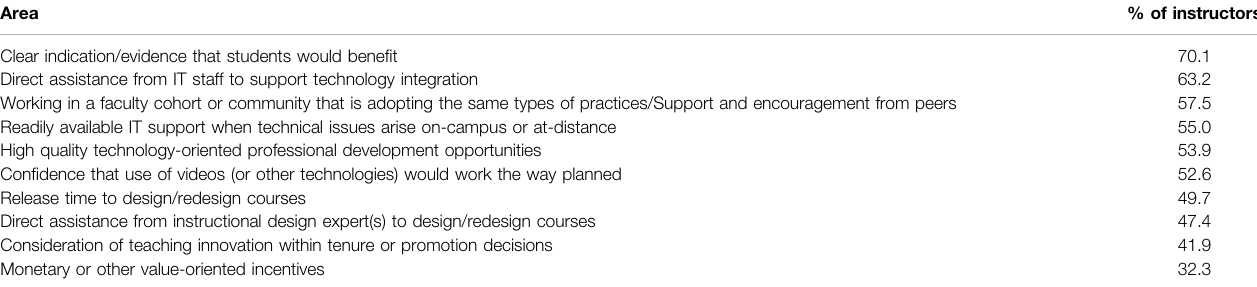
TABLE 2 | Percentage of instructors having ranked the importance of each area between 1 – 3 (1 (cid:1) highest importance ... 10 (cid:1) lowest importance). Area % of